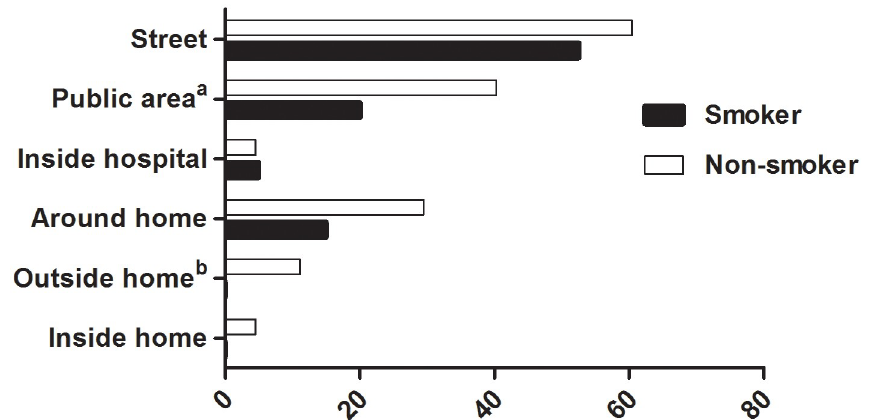
Fig 2. Places of exposure to secondhand smoke (%). Data expressed as percent. a p = 0.014, b p = 0.021 between smokers and non-smokers.